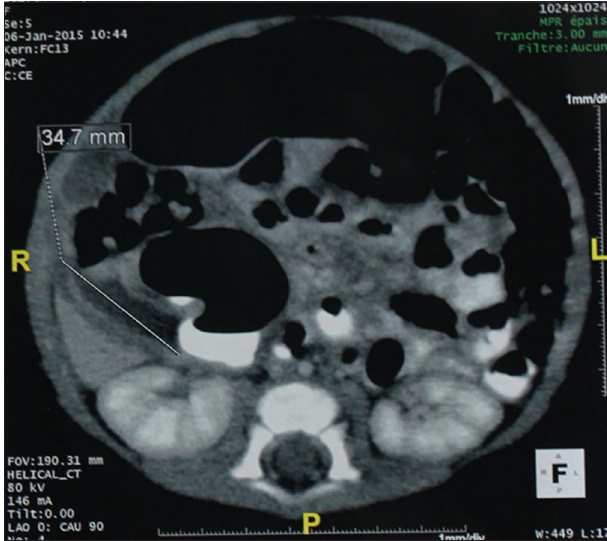
Figure 1: Computed tomography scan of the abdomen showed a 35 mm well-defined ovoid cystic structure, located in the right upper abdomen and adjacent to the second portion of the duodenum and to the head of the pancreas